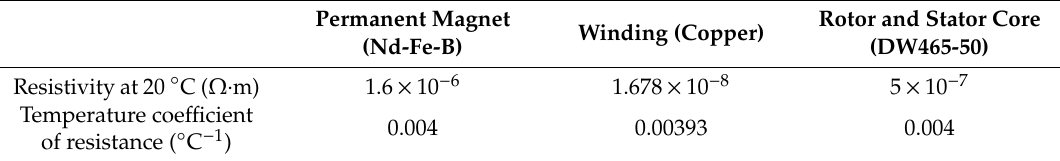
Table 3. The resistivity and resistance temperature coe ffi cient of